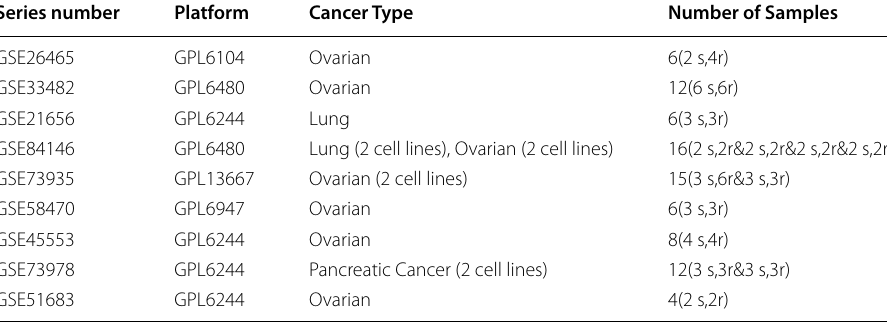
Table 1 Samples collected from NCBI GEO database Series